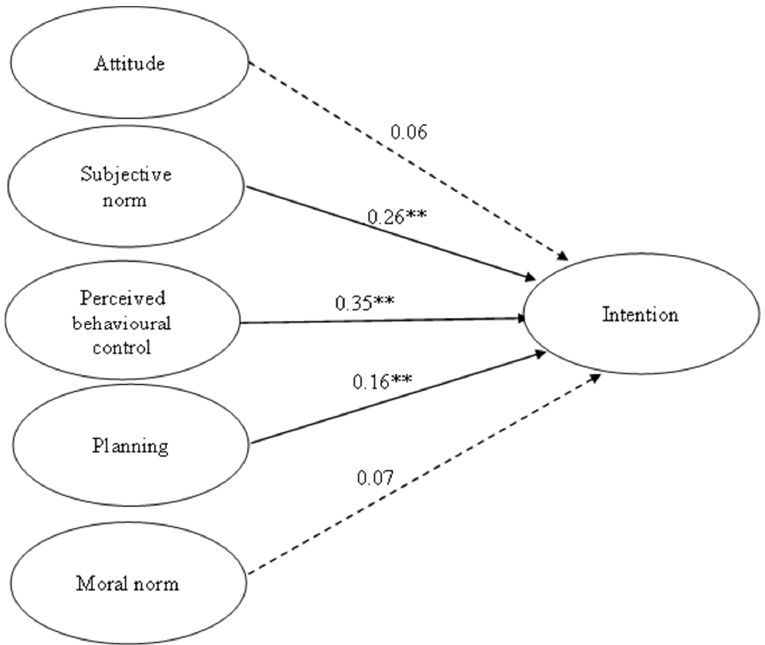
Figure 1. Structural equation model predicting intention to avoid driving into floodwater ** p < 0.01. Table 4. Standardized path coefficients and variability statistics for the structural equation model of intention to avoid driving into floodwater.